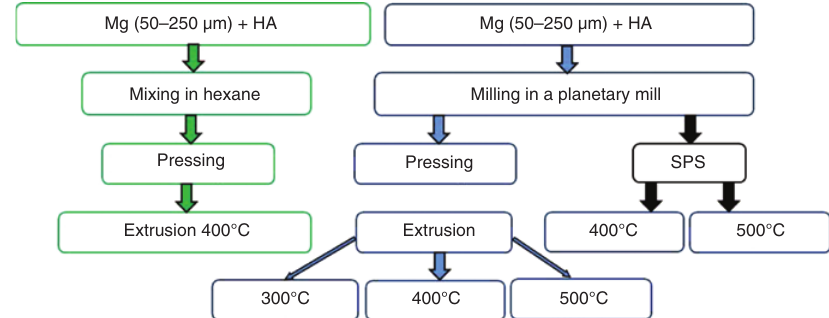
Figure 1: Preparation of composite